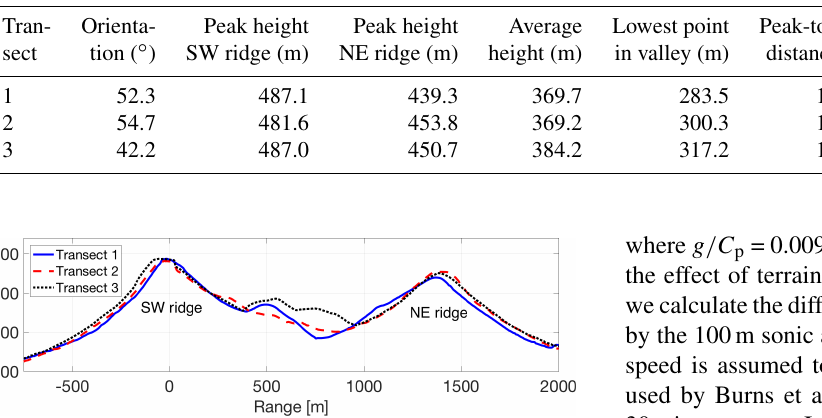
Figure 2. Elevation profiles of measurement transects. The transect colors correspond to Fig. 1. The vertical scale is exaggerated by a factor of 2. The origin (range of 0) refers to the positions of Wind- Scanners 105, 102 and 106 for transects 1, 2 and 3, respectively. The coordinates of the transects are available as CSV files in the Supplement.